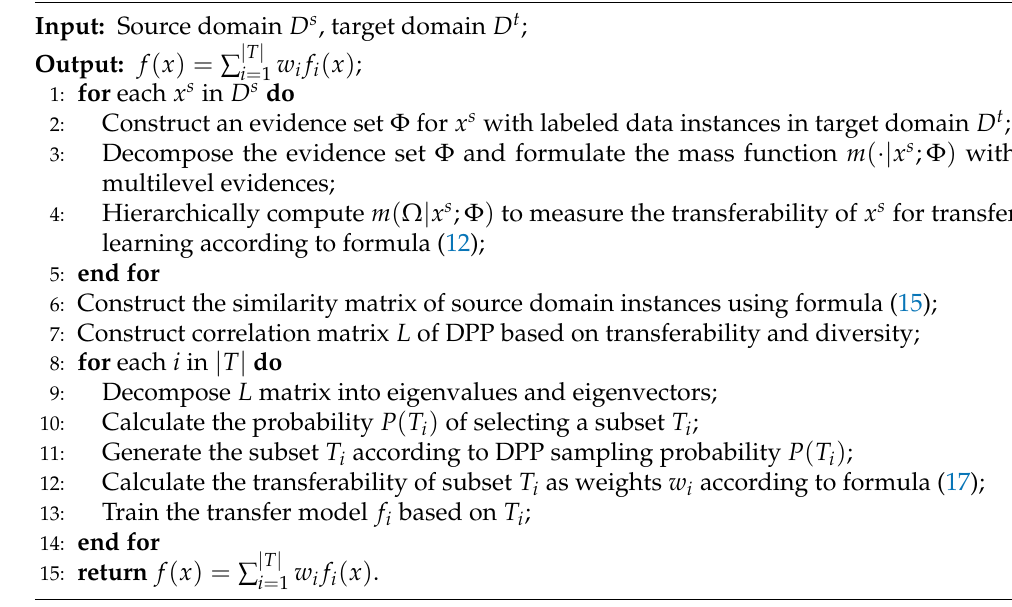
Algorithm 1 Ensemble strategy based on DPP sampling for transfer